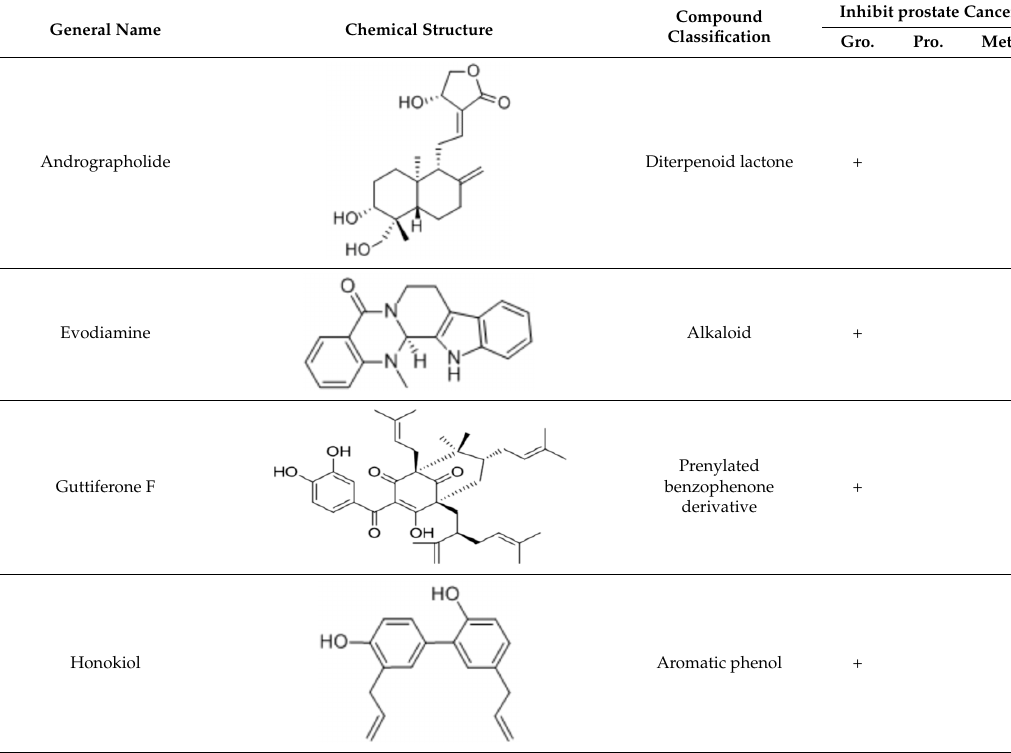
Table 2. Compounds isolated from Chinese medicines inhibiting prostate cancer.